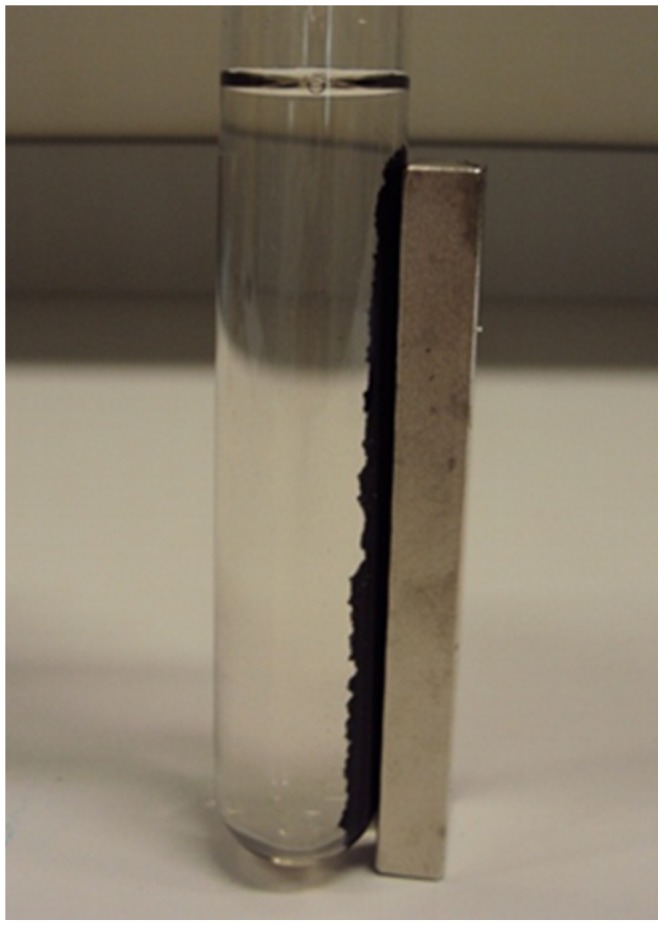
Testing the magnetic stability of magnetite-waste tea composite after 8 days in water.